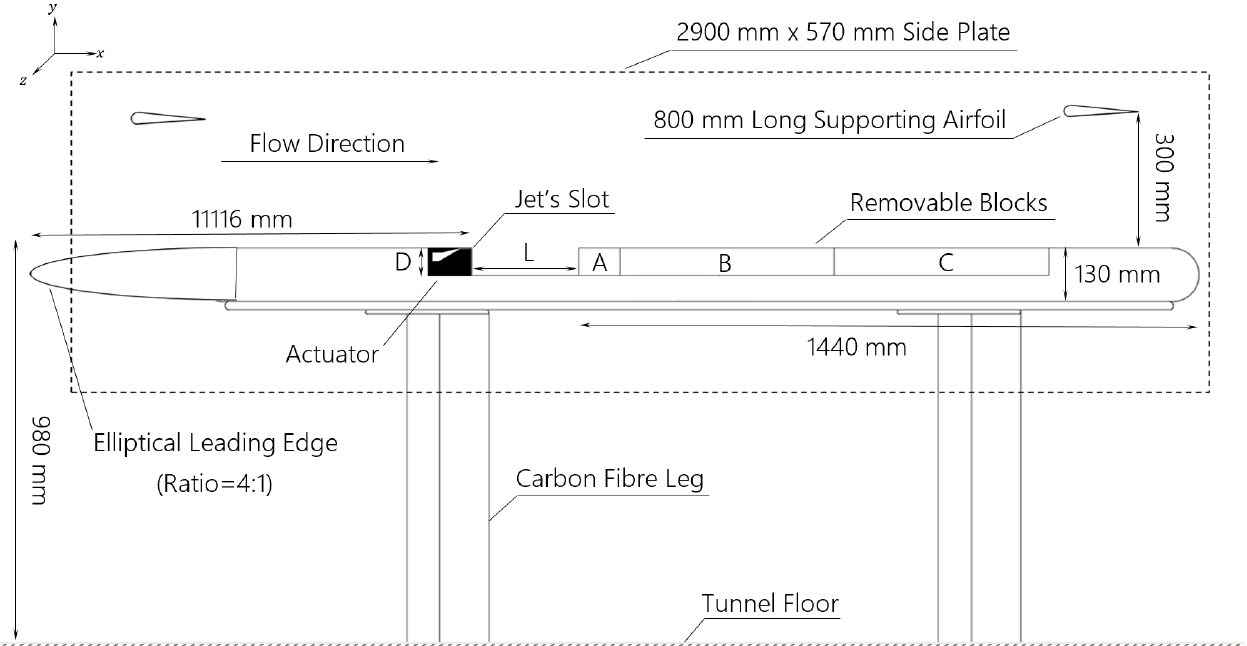
Figure 2. Side view drawing of the experimental